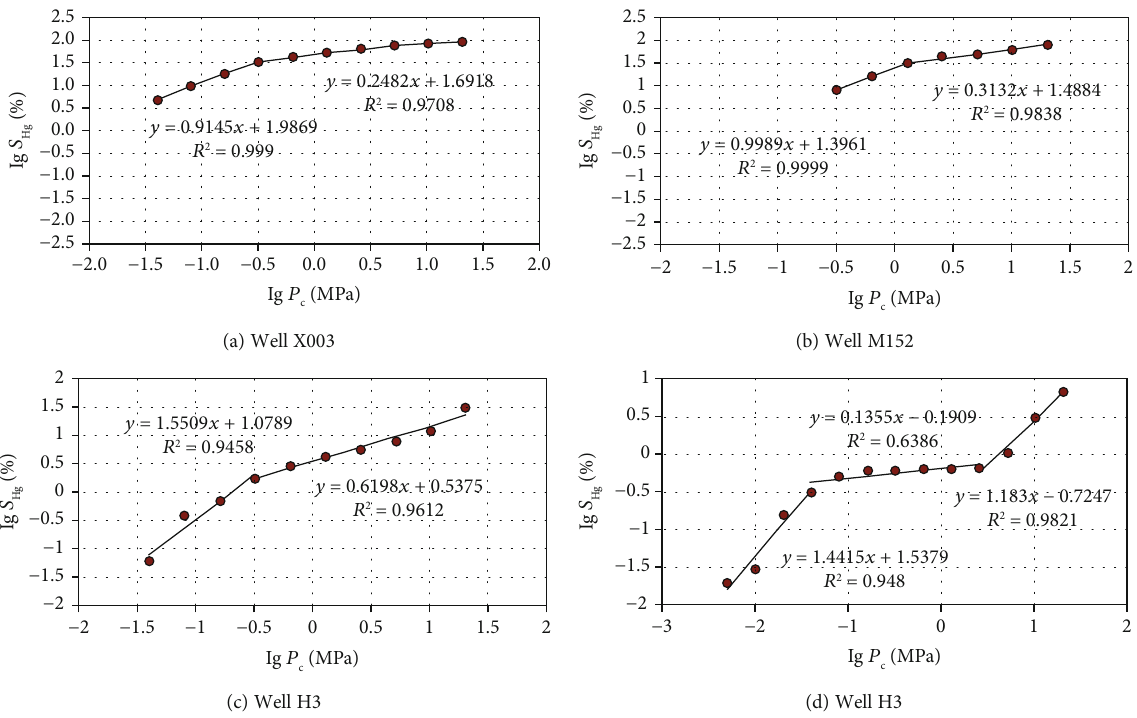
Figure 1: Multifractal and nonfractal characteristics of the capillary pressure curve of sand conglomerate